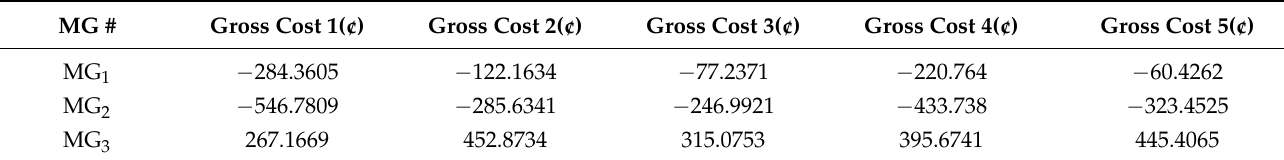
Table 9. Gross cost for five cases of scheduled load with fixed time slots using